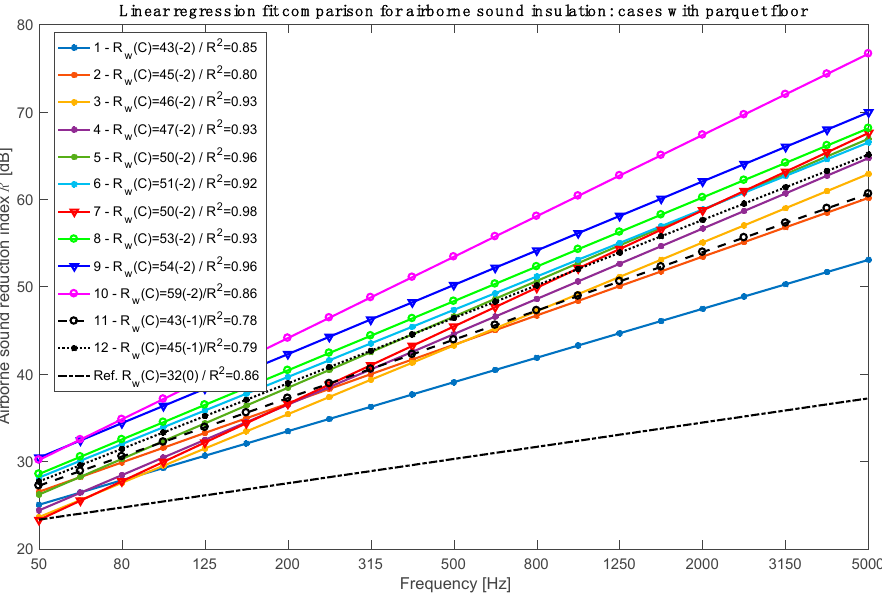
Figure 5. Linear models of airborne sound reduction index R curves of the test floors.